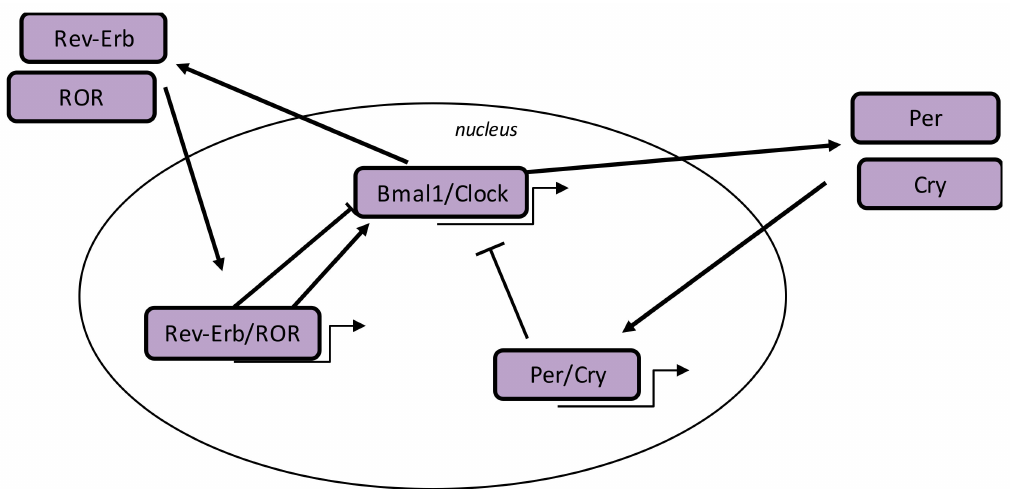
Figure 1. Circadian clock genes. The clock process is a stimulatory circle involving the Bmal1 / Clock heterodimer that activates the transcription of Per and Cry genes, and the inhibitory feedback circle with the Per / Cry heterodimer that translocates to the nucleus and represses the transcription of the Clock and Bmal1 genes. An additional circle implicates the RORs and Rev-Erb factors with positive feedback by RORs and negative feedback by Rev-Erb . Abbreviations: circadian locomotor output cycles kaput ( Clock ), brain and muscle aryl-hydrocarbon receptor nuclear translocator-like 1 ( Bmal1 ), period ( Per ), cryptochrome ( Cry ), and retinoid-related orphan receptors ( RORs